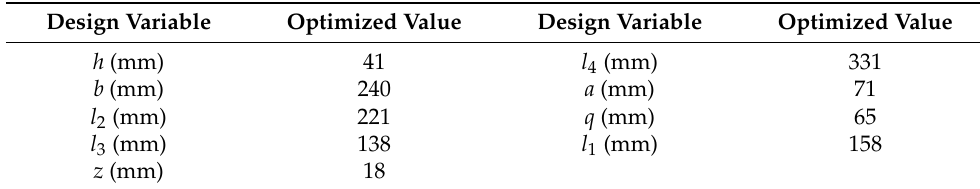
Figure 13. CO optimization strategy of the rotor mechanism. Table 4. Optimization values of the rotor mechanism design variables.